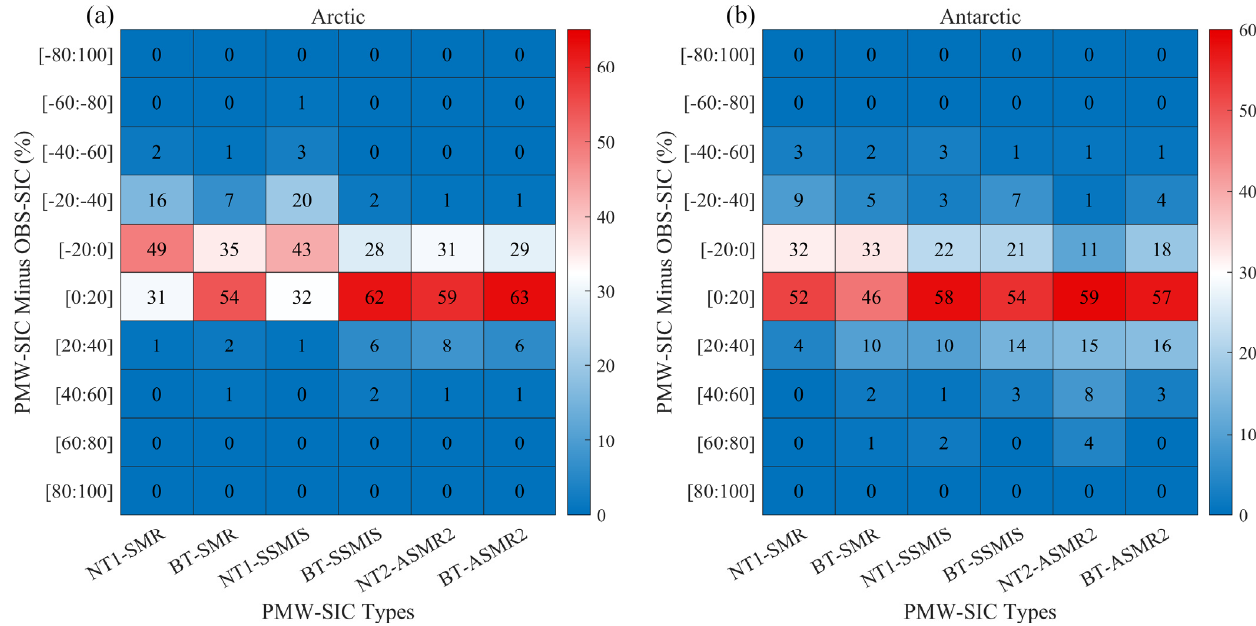
Figure 13. SIC differences between the PM SIC products and ship-based SIC. The number in the grid denotes the proportion of data pairs for the PM SIC products. The horizontal axes denote six different PM SICs. The SIC differences are grouped with an interval of 20% from − 100% to 100% (vertical axis). The ( a ) diagram indicates the Arctic and the ( b ) diagram indicates the Antarctic.